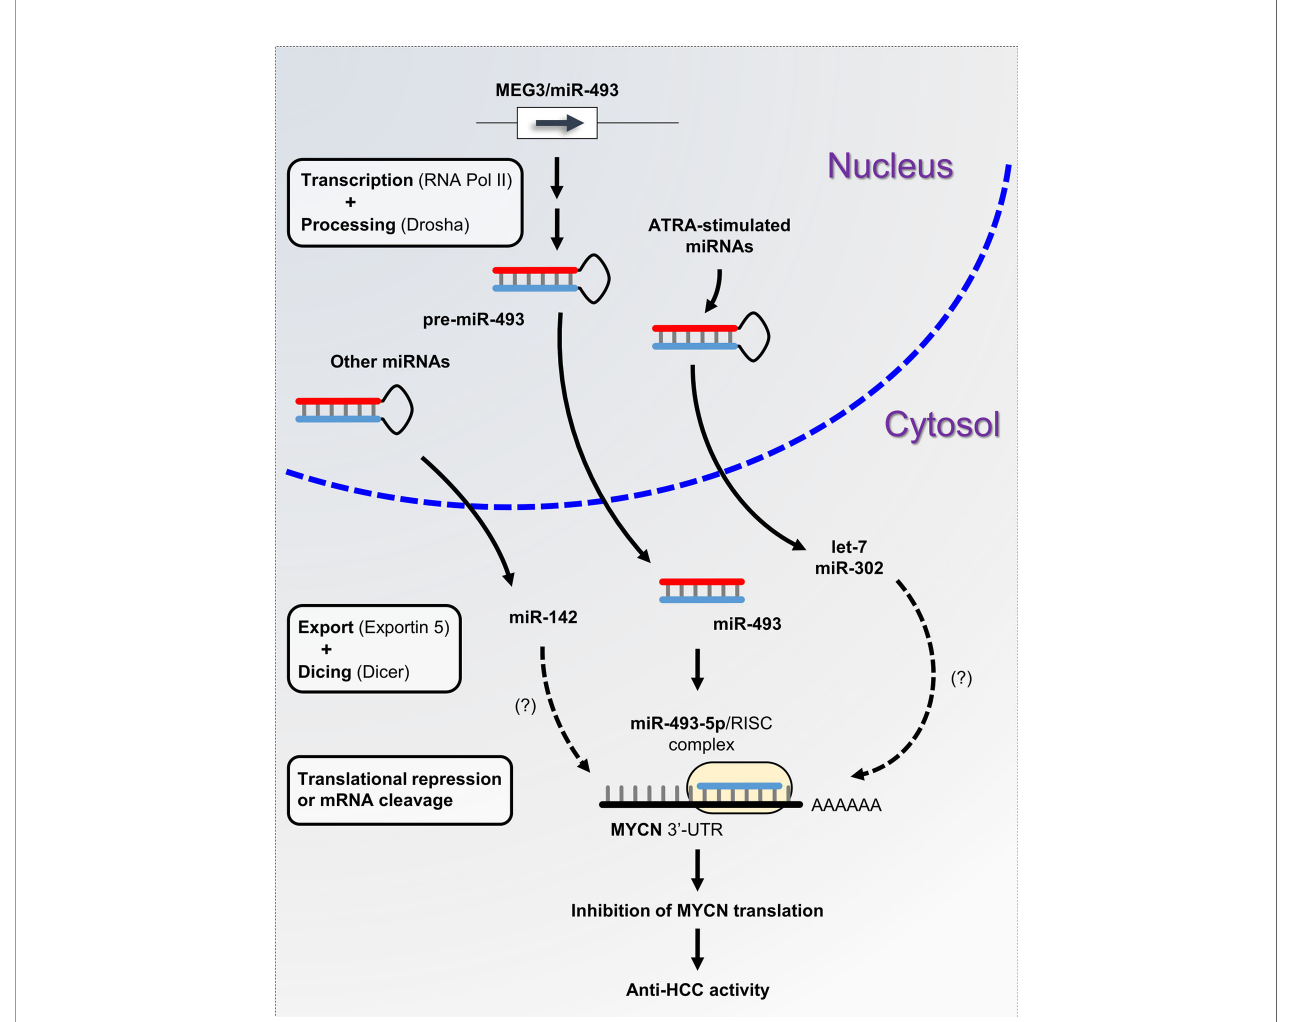
FIGURE 2 | miRNA-based control of MYCN gene expression in liver cancer. miRNA biogenesis is a multistep process. Following transcription by RNA polymerase II, primary precursor miRNAs (pri-miRNAs) are cleaved into precursor miRNAs (pre-miRNAs) by the RNase III enzyme Drosha and exported out of the nucleus to produce mature miRNAs. Subsequently, mature miRNAs are loaded onto the RNA-induced silencing complex (RISC) and directed to the 3 ’ -UTR of target mRNAs. Here, we propose the miRNA/MYCN regulatory network model, in which the tumor-suppressor miR-493-5p and the ATRA-stimulated miRNAs modulate MYCN expression and impede HCC